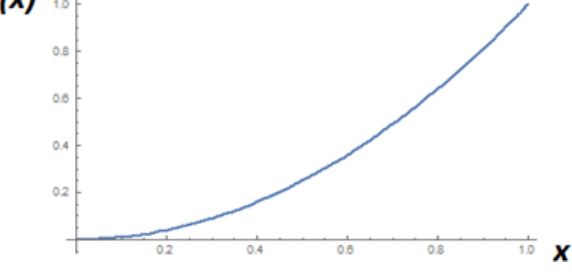
Figure 1: The original plane ( x , f ( x ) = x 2 )